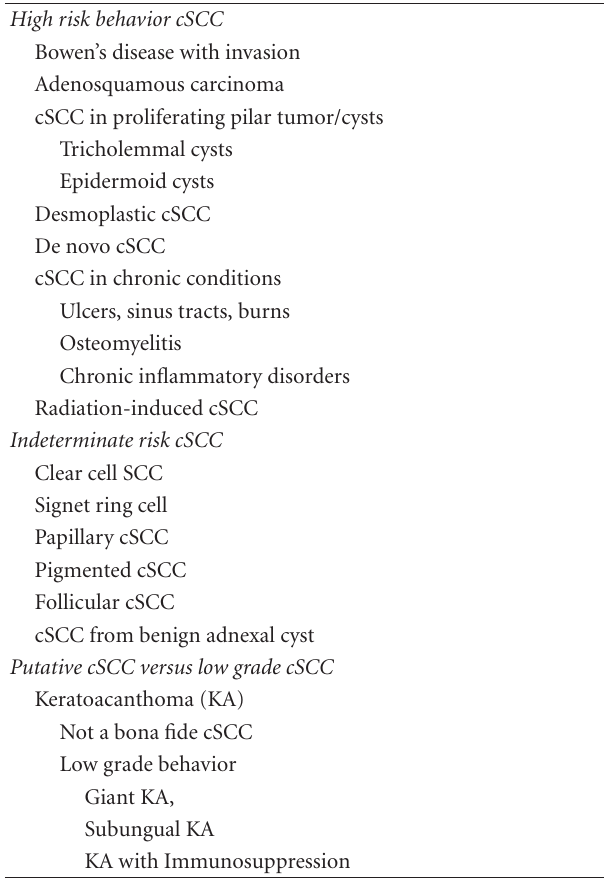
Table 2: Clinicopathologic classification for cSCC ∗